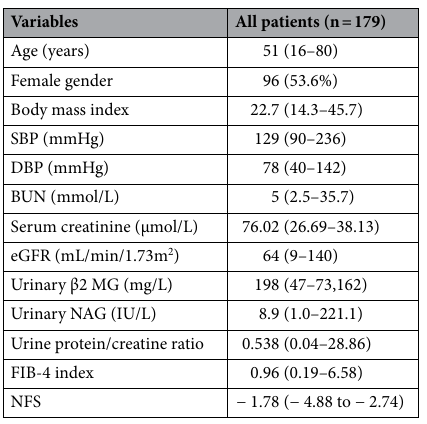
Table 1. Patient characteristics. SBP systolic blood pressure, DBP diastolic blood pressure, BUN blood urea nitrogen, eGFR estimated glomerular filtration rate, urinary β2 MG urinary β2 microglobulin, urinary NAG